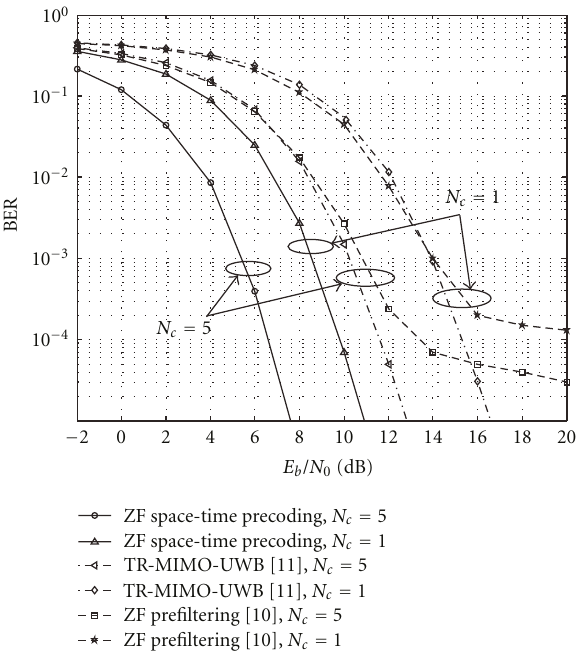
Figure 5: BER performance comparison between the proposed scheme and other schemes when imperfect CSI presents. N t = 4, N r = 2, and T s = 10